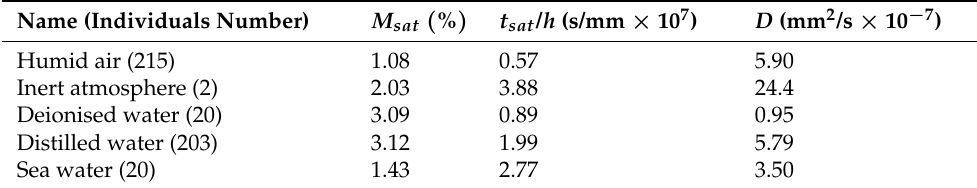
Table 7. Medians of M sat , t sat / h and D as a function of the conditioning environment. Entire box plots are available as Supplementary Materials (Figures